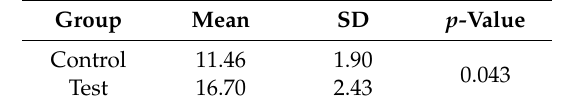
Table 2. Tensile strength of membranes in wet state (unit: N) ( n = 5).